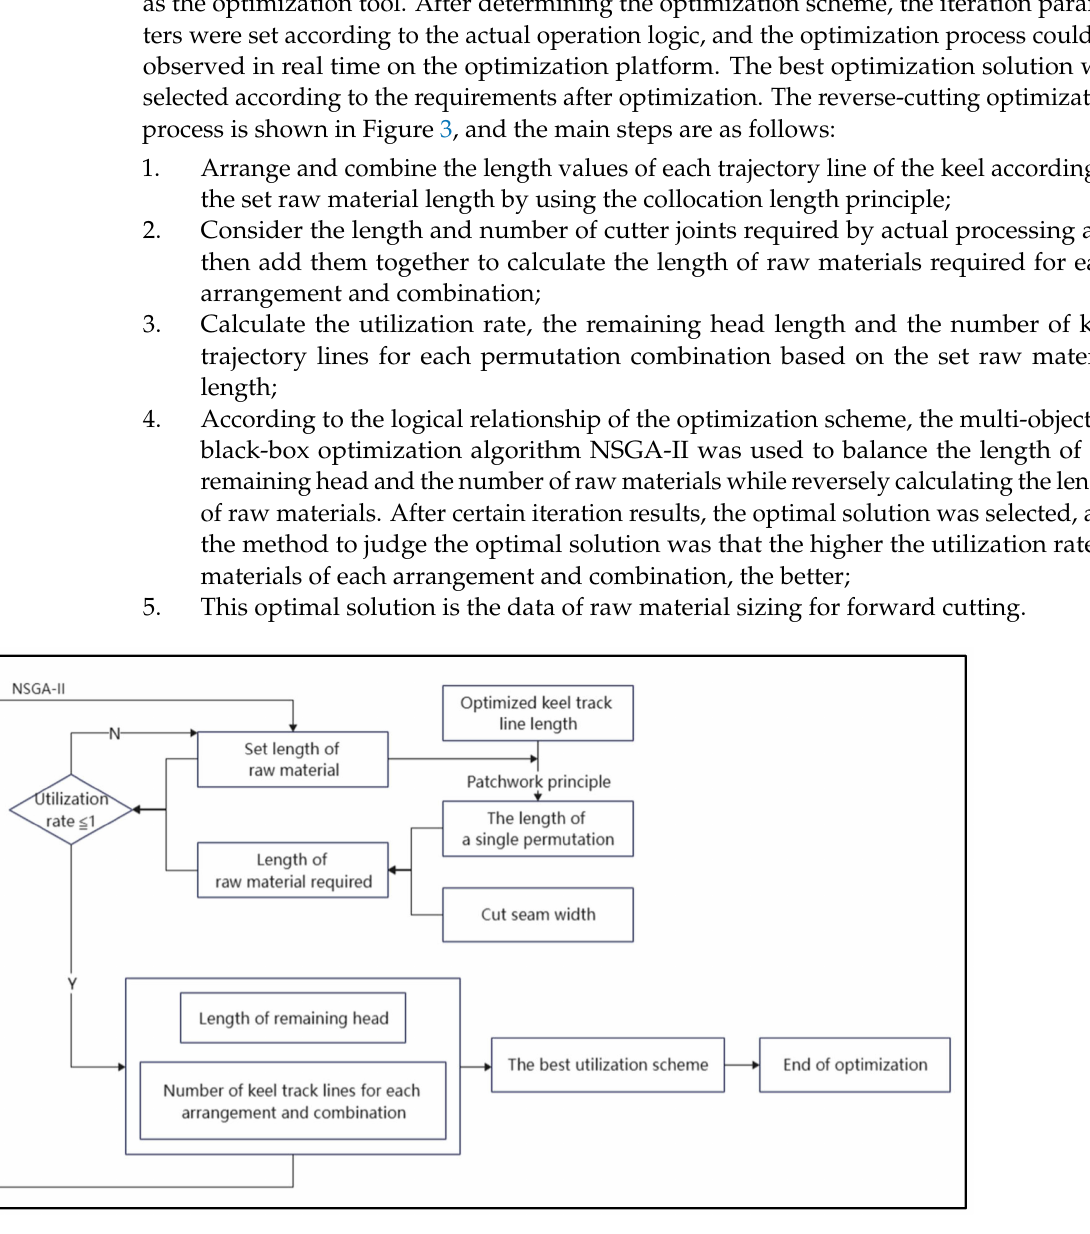
Figure 3. Reverse-cutting optimization